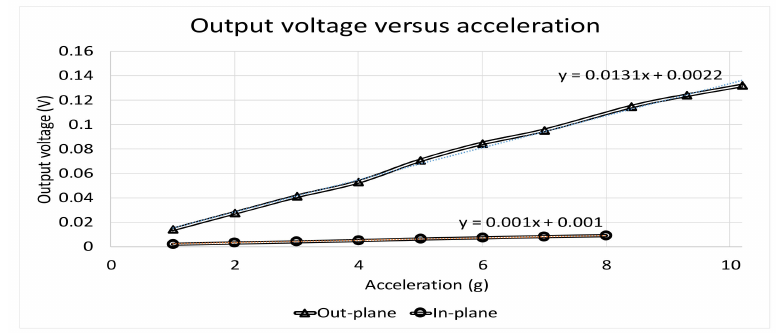
Figure 29. Measurement results of the output voltage versus acceleration.